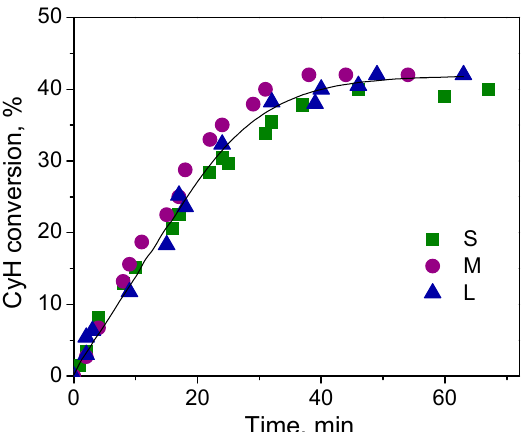
Figure 4. The kinetic curves for CyH oxidation with H 2 O 2 over MIL-125 with different particle sizes. Reaction conditions: CyH 0.1mmol, H 2 O 2 0.1 mmol, catalyst 0.01 mmol Ti, HClO 4 0.01 mmol, CH 3 CN 1 mL, 50 °C.